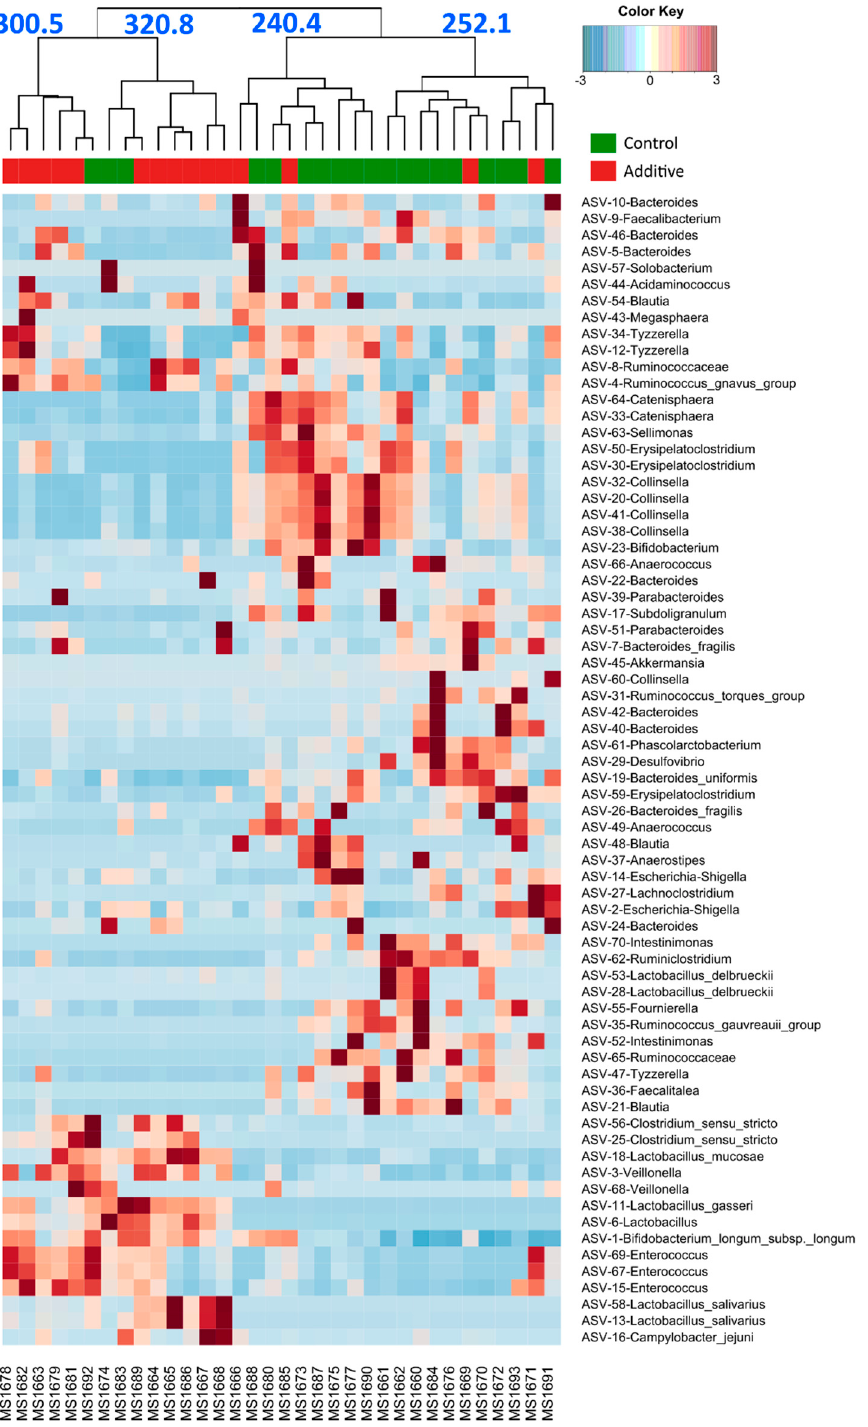
Figure 5. Heatmap showing the distribution of the 70 most abundant ASVs (ASV appear in the y-axis at the right side of the figure with their taxonomic assignation according to the SILVA database) in control- (green) or additive- (red) diet lamb fecal samples. The heatmap ranges from dark blue (less occurrence) to dark red (more occurrence), indicating if the di ff erent ASVs were more occurrent and abundant in the di ff erent samples. The blue numbers in the upper side of the figure represent the mean daily weight gain (g) of the samples that are included in each of the four main branches of the clustering tree. The names in the x-axis at the bottom of the figure correspond to the code given to each lamb.